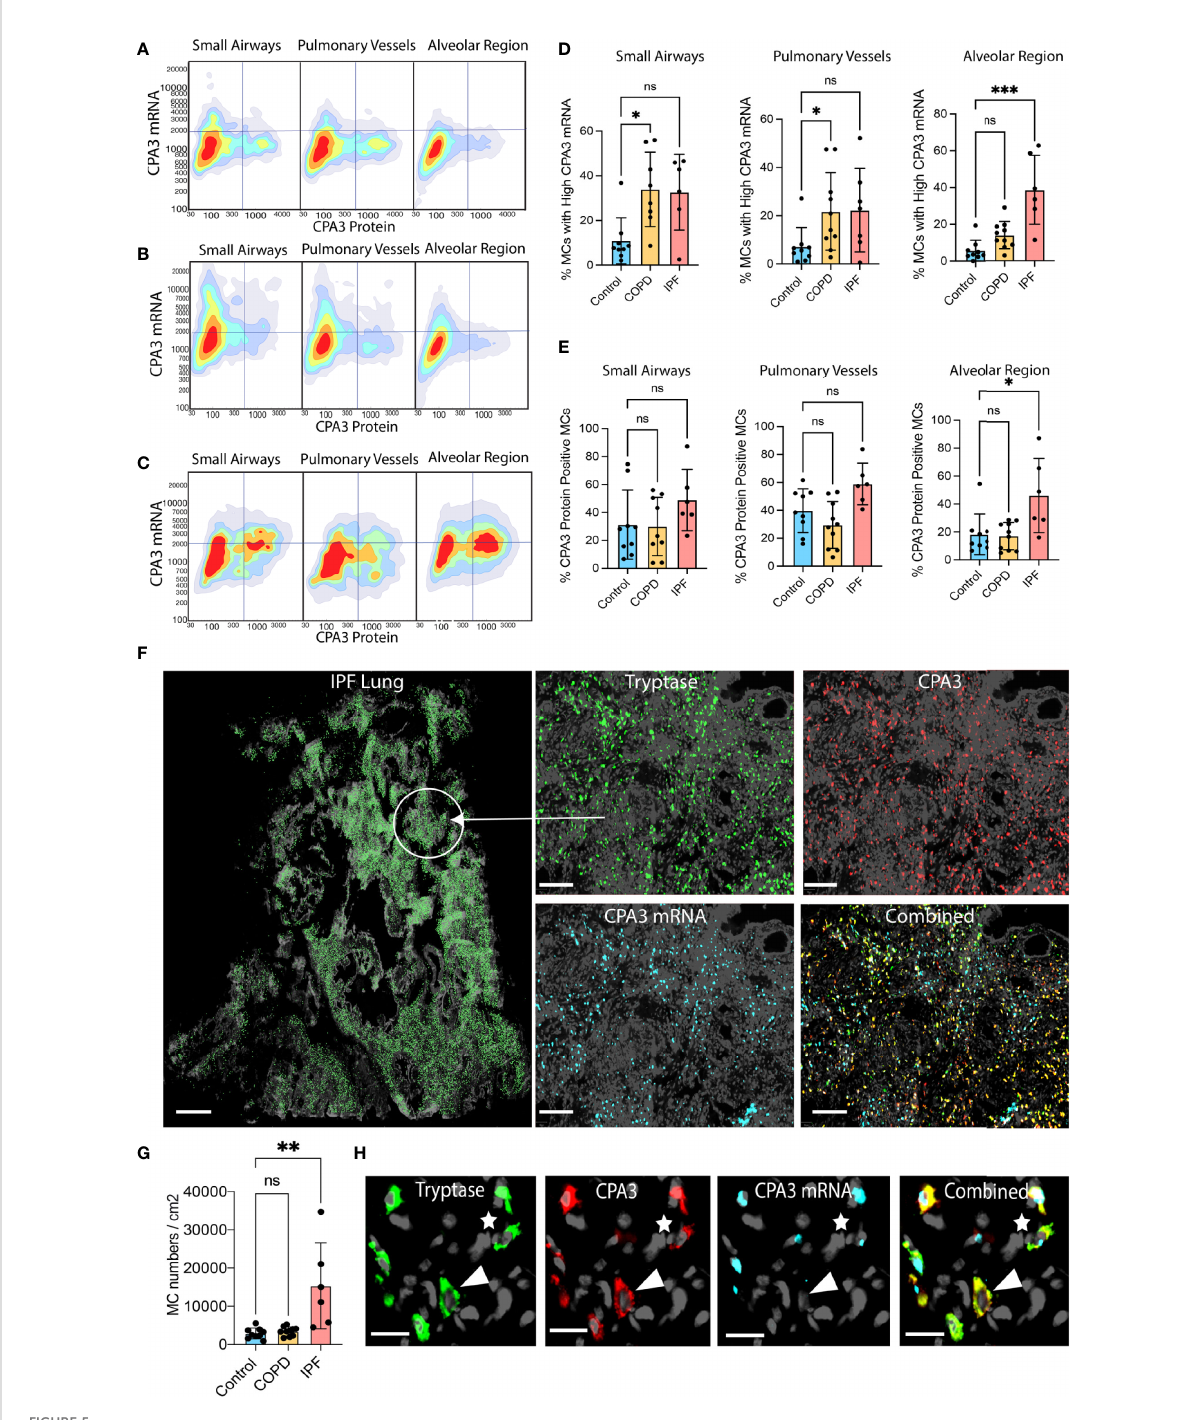
FIGURE 5 Disease-speci fi c small airway and alveolar CPA3 responses in COPD and IPF. (A – C) 2D scattergrams showing CPA3 mRNA and protein relationships across pooled mast cells from control lungs (A; n = 18,504 pooled MCs), COPD (B; n = 41,313), and IPF cases (C; n = 81 806). (D, E) Mean patient percentage of lung mast cells with a high CPA3-mRNA pro fi le (D) or CPA3 protein (E) within anatomical regions and disease categories (as de fi ned by a pre-determined locked threshold values). (F) Low-power graph exemplifying the very high density of mast cells in distal IPF lung. To visualize individual mast cells, their x , y coordinates have been replaced with pseudo-colored green circles (left). The right quartet set of images shows the original fl uorescence-based staining in a zoomed-in region. (G) Mean patient lung mast cell density levels. Statistical signi fi cance levels are marked as ns = non-signi fi cant, * p < 0.05, ** p < 0.01, *** p < 0.001. (H) Zoomed-in ICH and IHC fl uorescence images exemplifying a CPA3mRNA - , protein + MC (arrowhead) and a CPA3mRNA + , protein + MC (* uppermost right corner). Scale bars: H = 25 m m, F-left = 1.8 mm, F-right =200 m